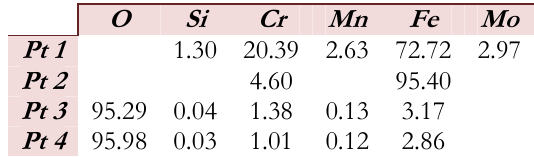
Table 2: EDS analysis (weight%) of areas shown in the Fig. 15.